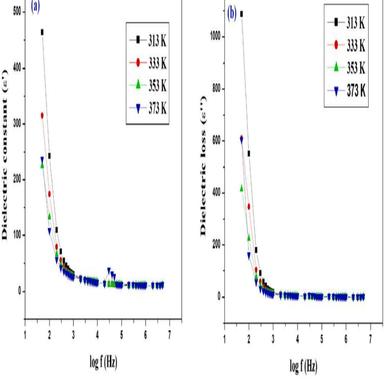
Variation of log F verses (a) Dielectric constant (b) Dielectric loss.